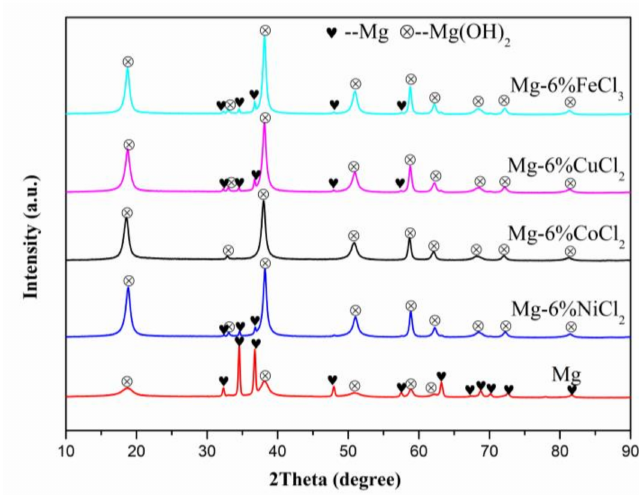
Figure 6. XRD of products after Mg-chlorides reacted with